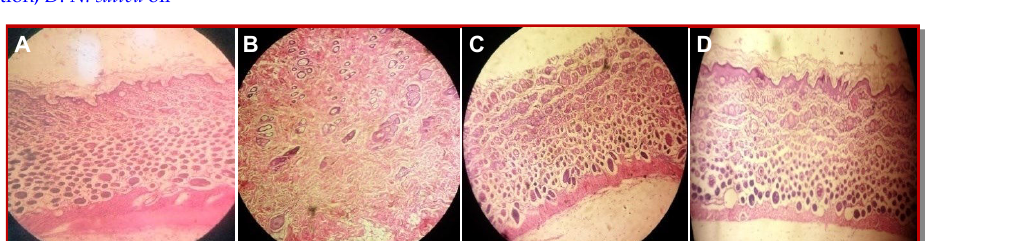
Figure 6: Macroscopic changes in different groups on day 7 of experiment; A: normal control, B: disease control, C: 5% N. sativa decoction, D: N. sativa oil